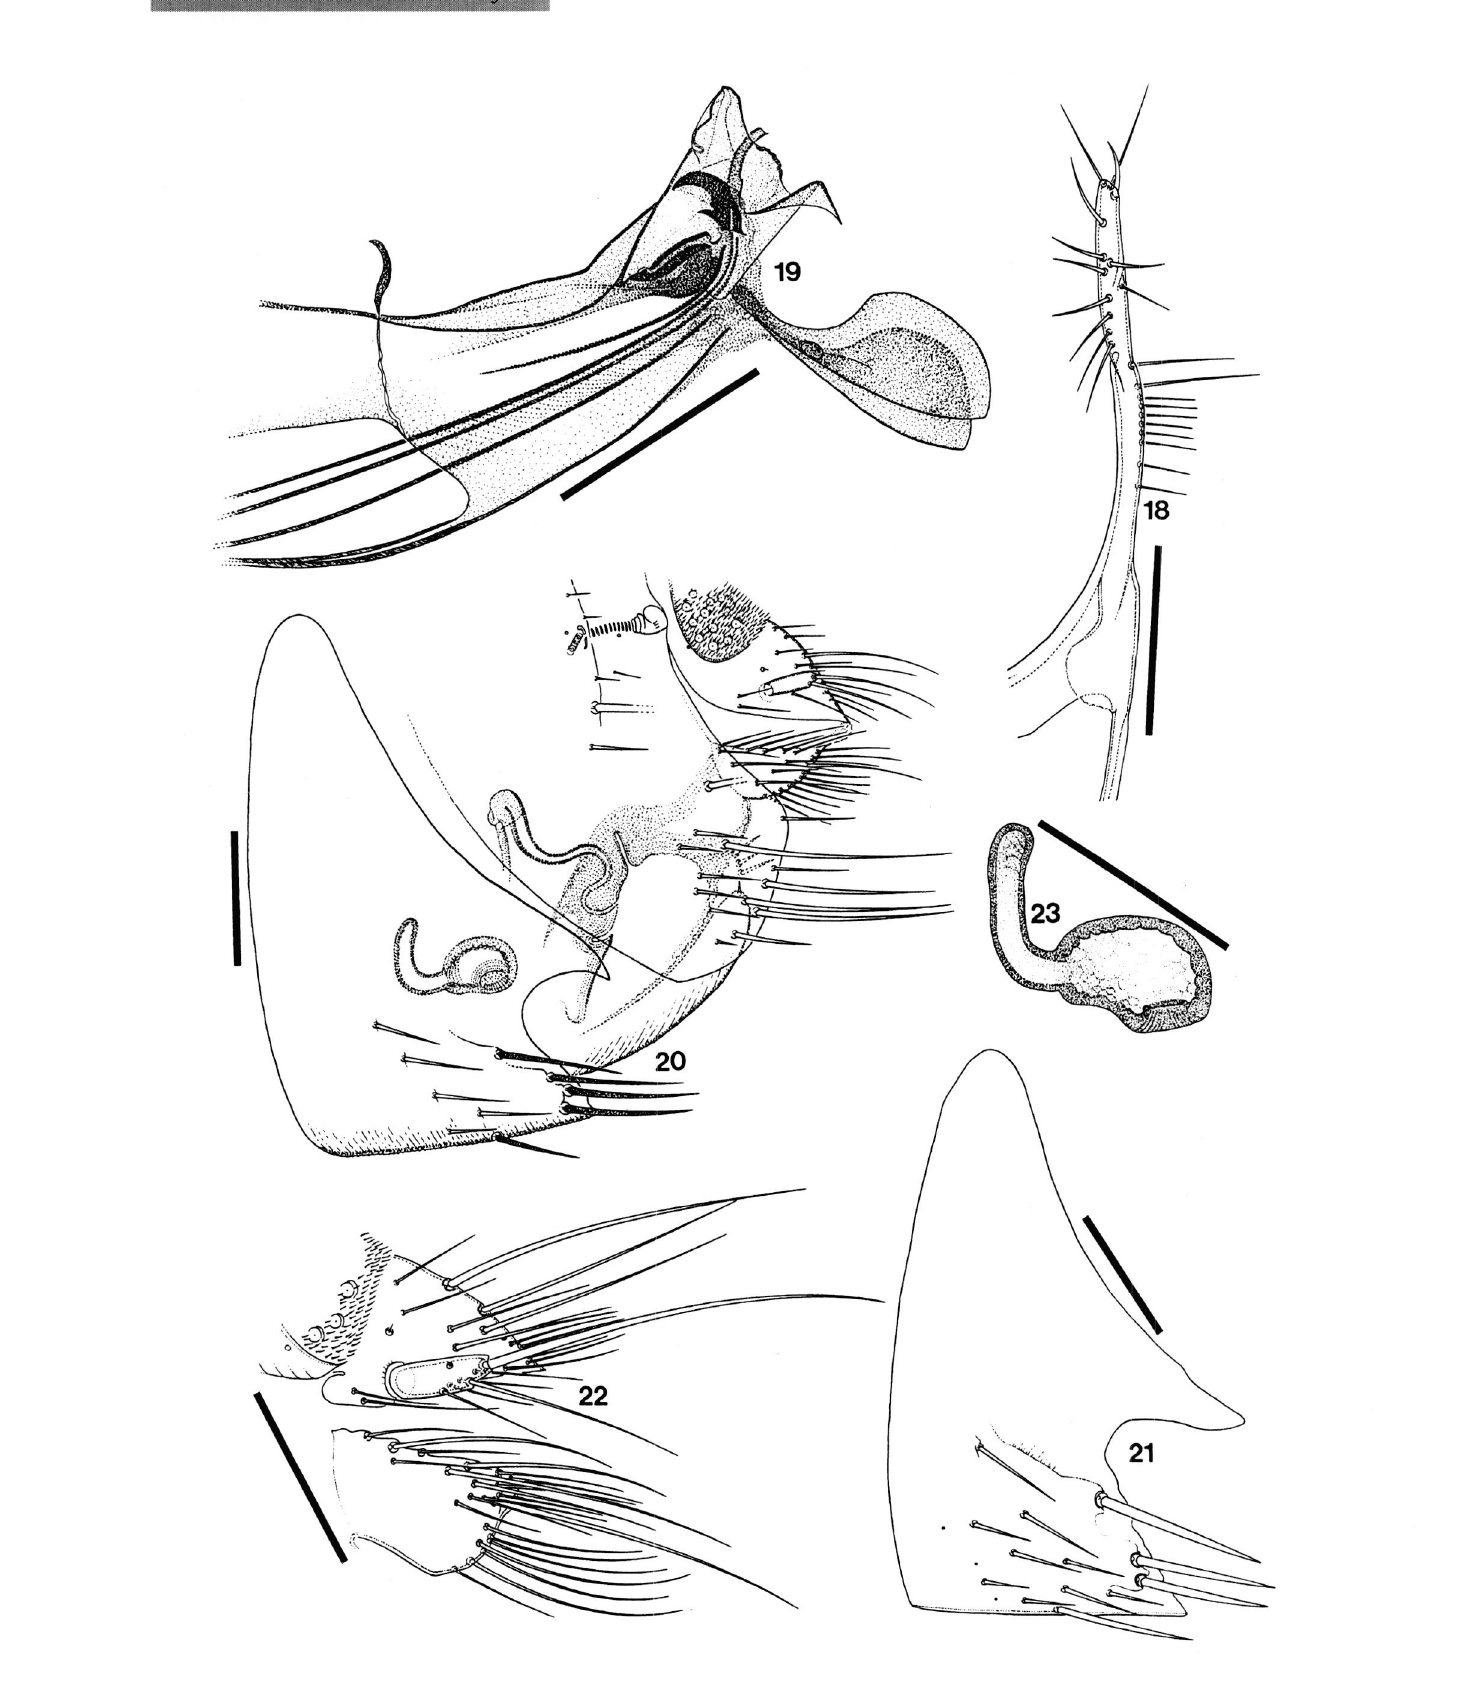
Figs 18-23 - Sigmactenus alticola pilosus n. ssp. 18: Sternite LX of male. 19: Phallosome of male. 20: Sternite VII, tergite VIII, spermatheca and adjacent structures of female. 21: Sternite VII of female. 22: Anal valves and anal stylet of female. 23: Spermatheca of female. All scale bars = 0,1